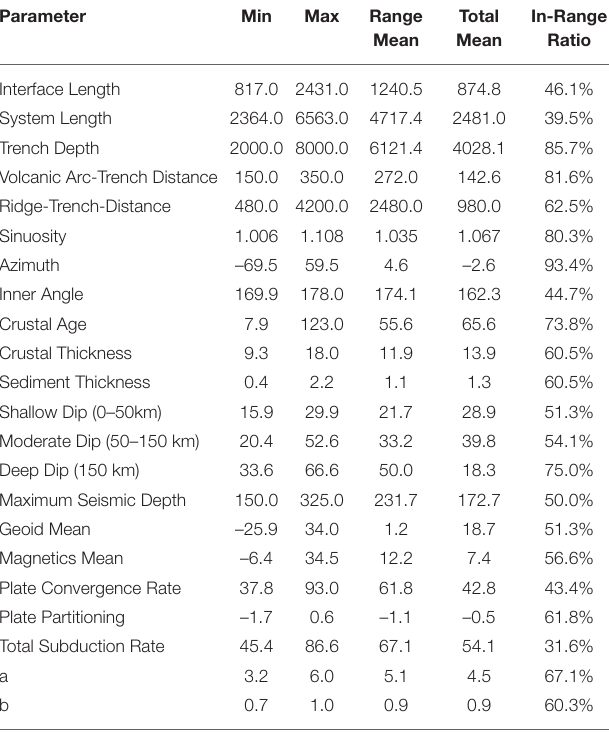
TABLE 3 | Overview of the assessed subduction zone parameter ranges for the historic M max . Parameter Min Max Range